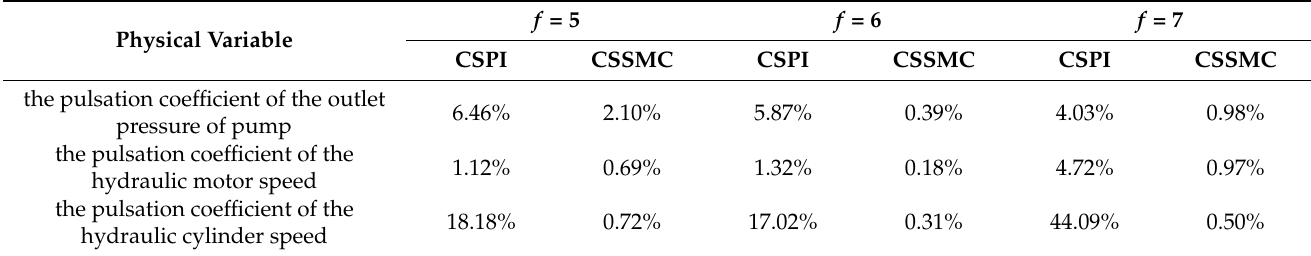
Table 2. Pulsation analysis of the CSPI and CSSMC.